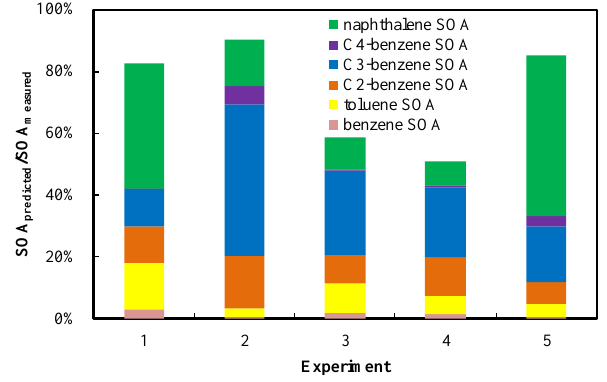
Figure 5. Contributions of the predicted benzene SOA, toluene SOA, C 2 -benzene SOA, C 3 -benzene SOA, C 4 -benzene SOA and naphthalene SOA to the total formed SOA in all experiments.